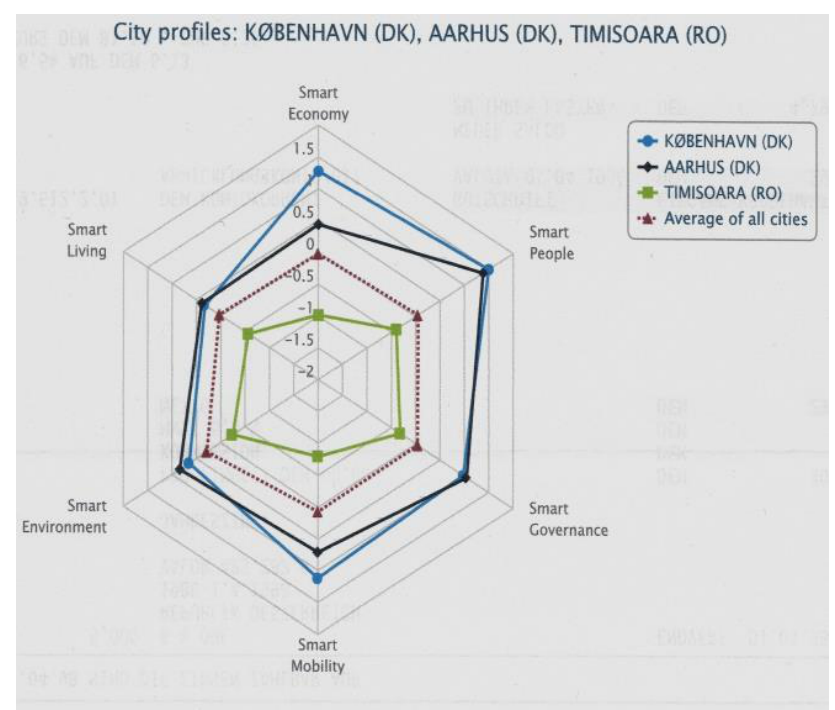
Figure 10. Comparison of three European cities (Copenhagen, Aarhus and Timişoara), based on the elements in figure 9 describing a smart city